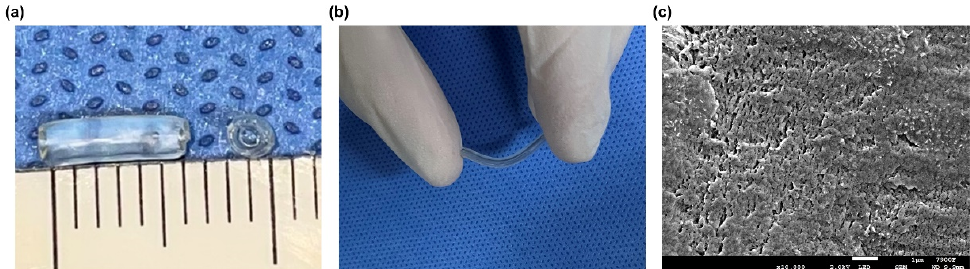
Figure 4. The morphology and stemness-related properties of BMSCs spheroids. ( a ) Schemes of hanging drop method to culture BMSCs spheroids. ( b ) Gross view of the fabrication process of BMSCs spheroids. ( c ) Representative image of BMSCs spheroids. Scale bar = 50 µm. ( d ) Immunoflu- orescence image of BMSCs using phalloidin and DAPI staining. Scale bar = 50 µm. ( e – g ) mRNA expression levels of Nanog, Sox2, and POU5F1 in different cultures of BMSCs. ** p < 0.01, vs. BMSCs